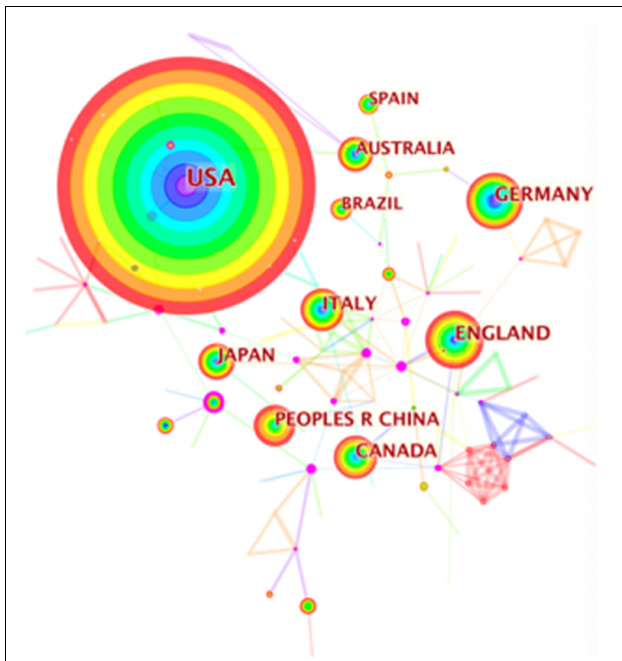
centrality was zero, indicating that there is little connection between the